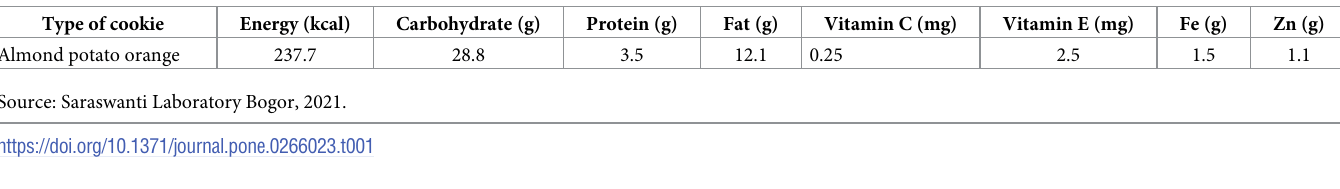
(Table 1). Cookies were made using a mixer, digital oven, baking sheet, cookie dough cutter, and digital kitchen scale. The ingredients of the cookies comprised potato flour, almond flour, orange jam, eggs, refined white sugar, butter, and pandanus/strawberry paste/flavoring. The cookies were made from 1–2 kg of potato starch, 0.5–1 kg of almond flour, and 1–2 kg of orange jam. The ratio of these ingredients was 2:2:1. The cookies were prepared freshly every week, each time with different batches of product to minimize the loss of vitamins and miner- als during the storage process. The orange almond potato cookies were analyzed for macro-